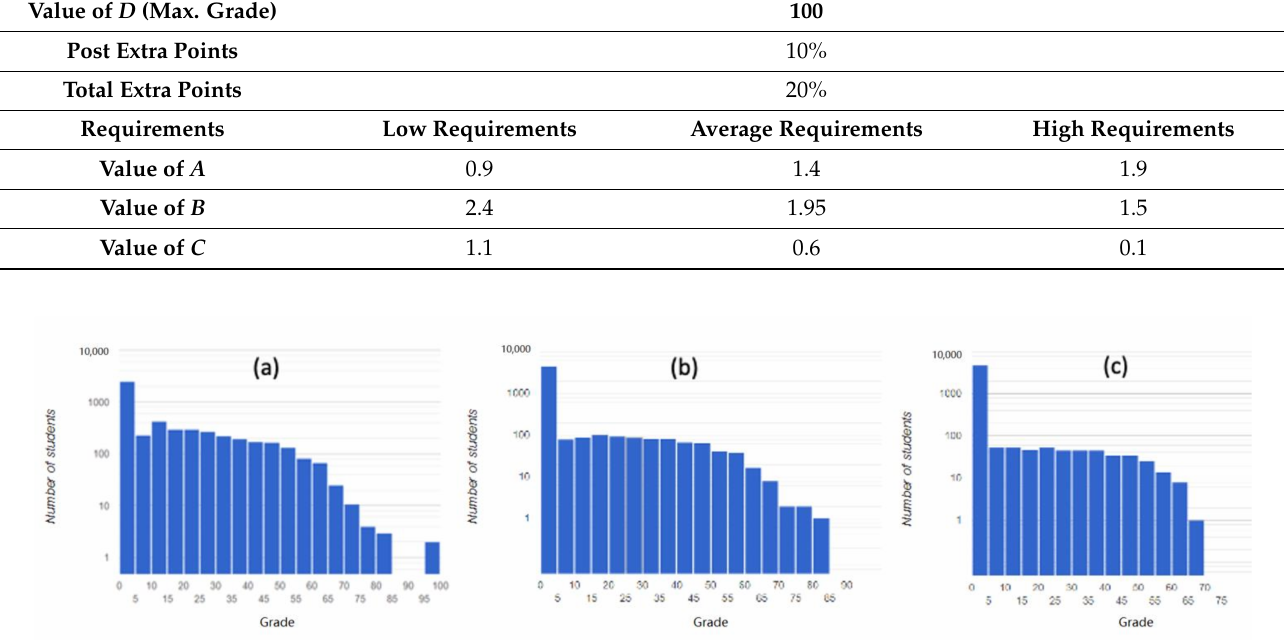
Figure 10. Histogram with the forum grades ( x -axis, from 0 to 100) and the number of learners ( y -axis, logarithmic scale): ( a ) Low requirements. ( b ) Average requirements. ( c ) High